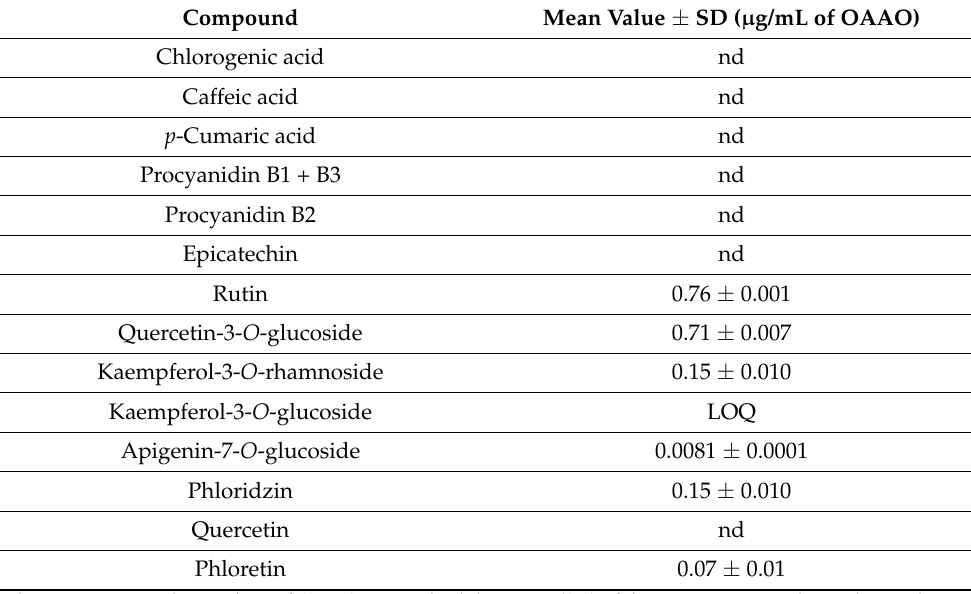
Table 2. Quantitative analysis of OAAO evaluated by HPLC-DAD-FLD